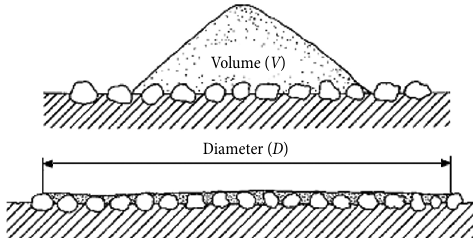
Fig. 1. The test method used to assess the surface texture